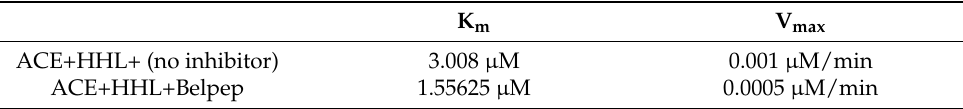
Table 2. ACE inhibitory kinetics parameters of the peptide identified from ultrafiltered BBPHA 120 ( Bellamya bengalensis alcalase hydrolysate at 120